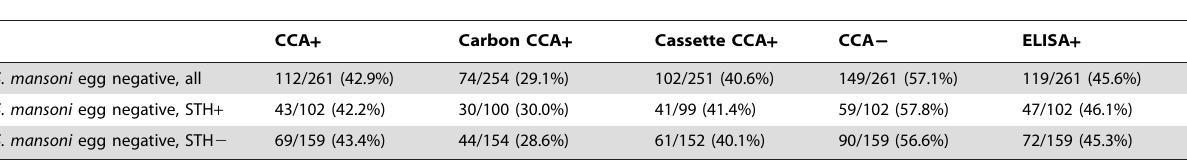
Table 3. Urine CCA assays are not affected by STH infection status.